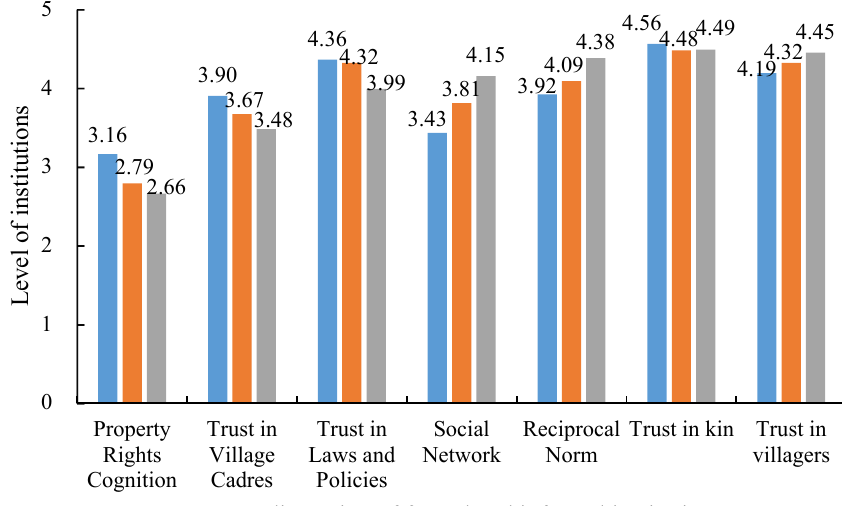
Figure 4. Descriptive statistics of focus variables in different village locations.